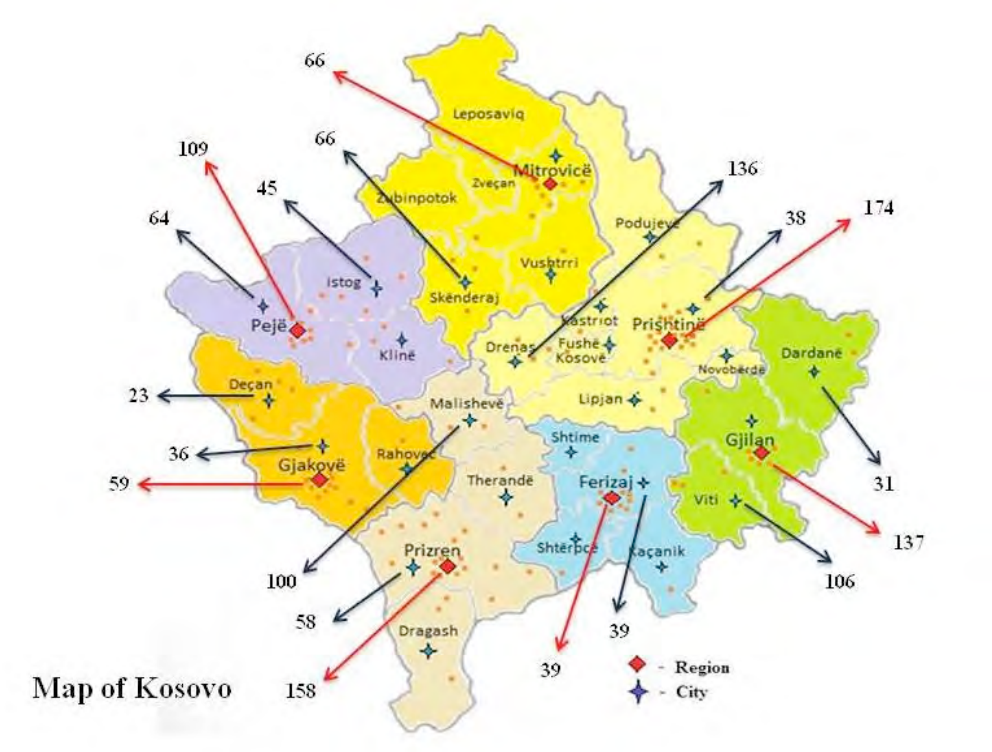
Figure 1. The regions and cities included in the sampling of the